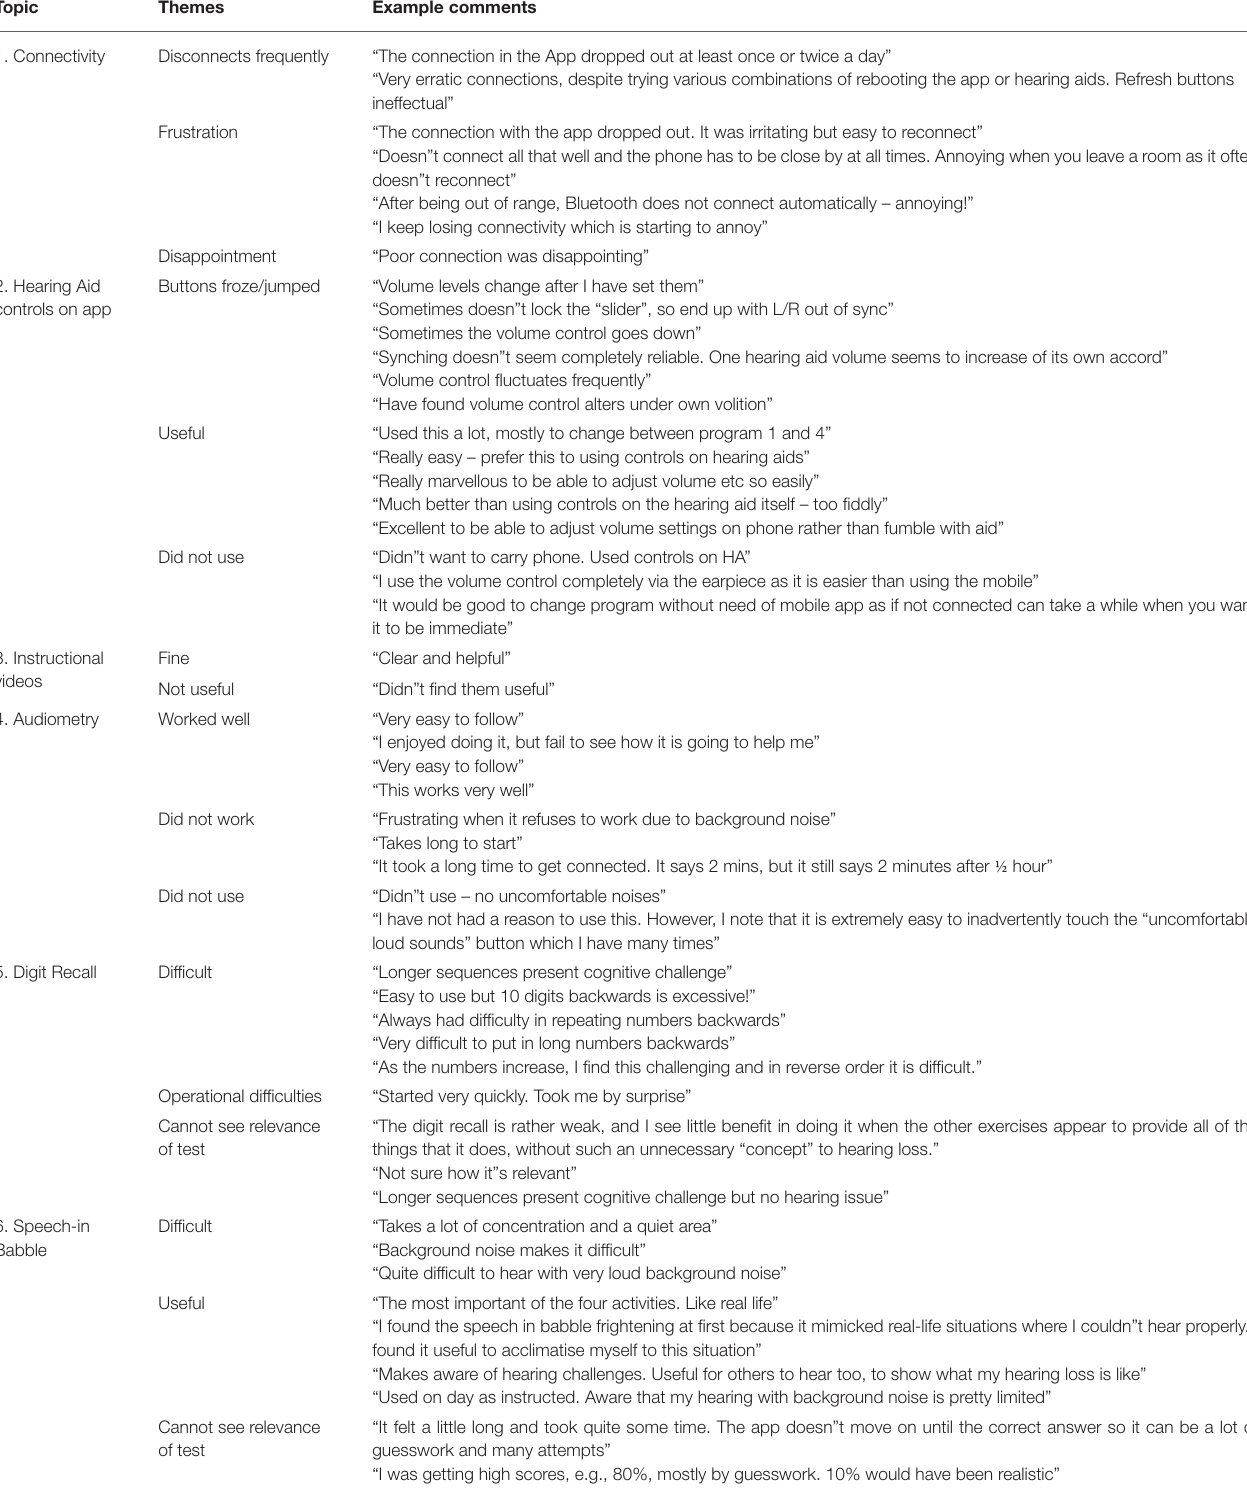
TABLE 3 | Example extract of comments from the data, giving an overview of topics and themes, are given